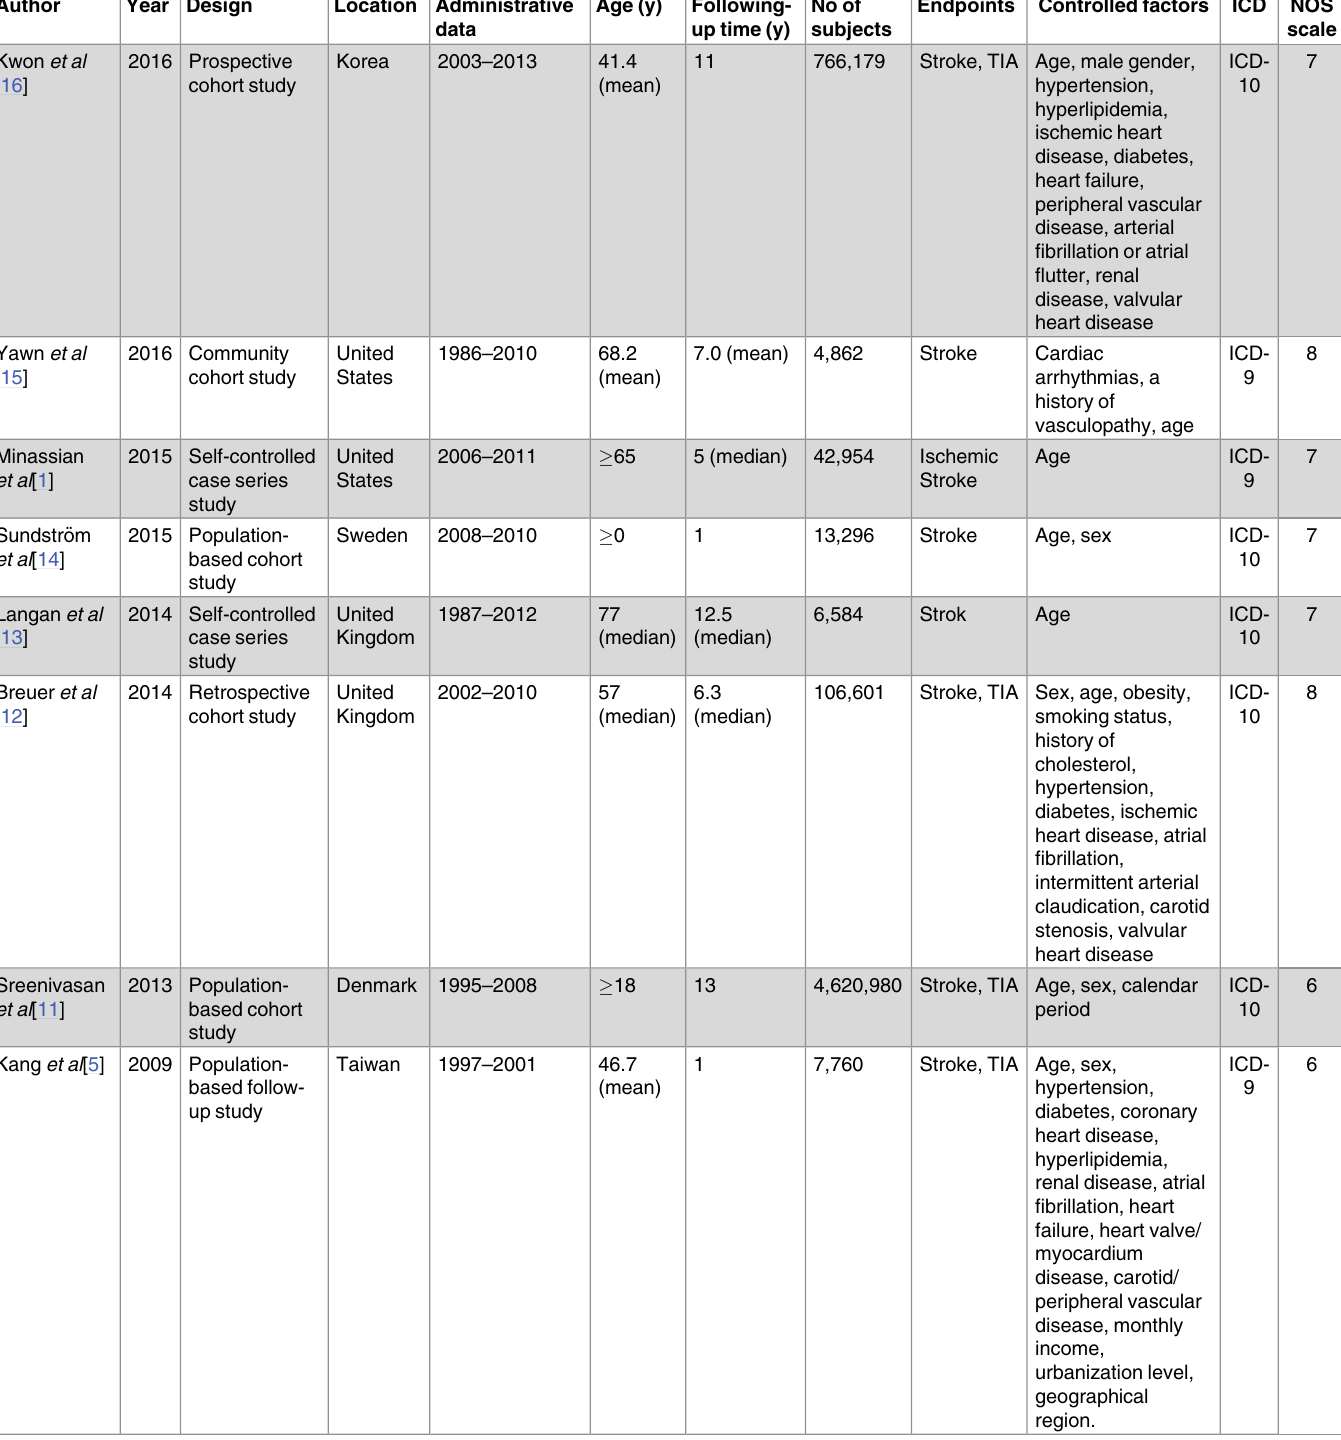
Table 1. Characteristics of studies included in the